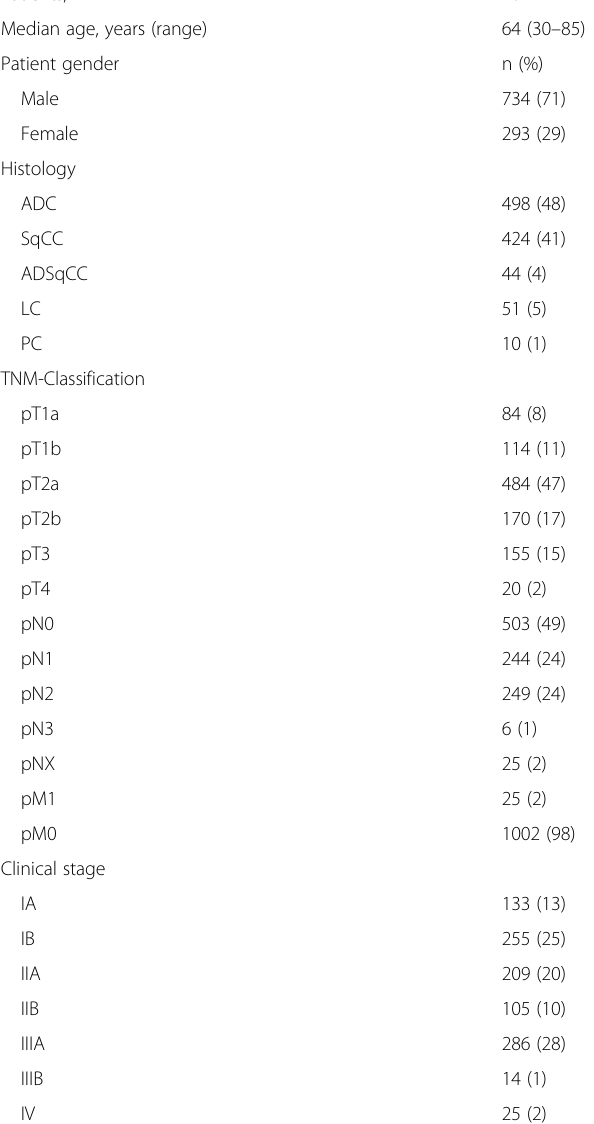
Table 1 Clinical characteristics of the cohort Patients,